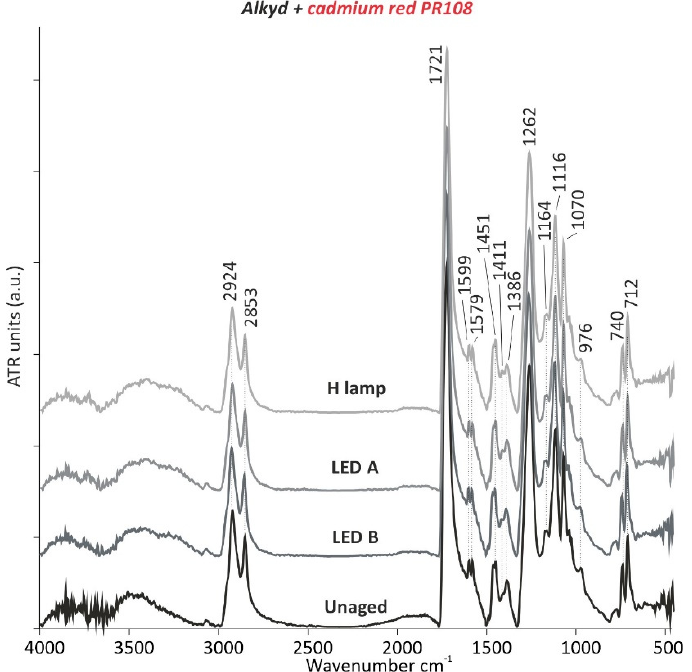
Figure 4. µ-ATR-FTIR spectra of alkyd with the cadmium red PR108 pigment before and after 5000 h of light ageing (LED A: 420 nm, LED B: 460 nm, and H lamp: halogen lamp).